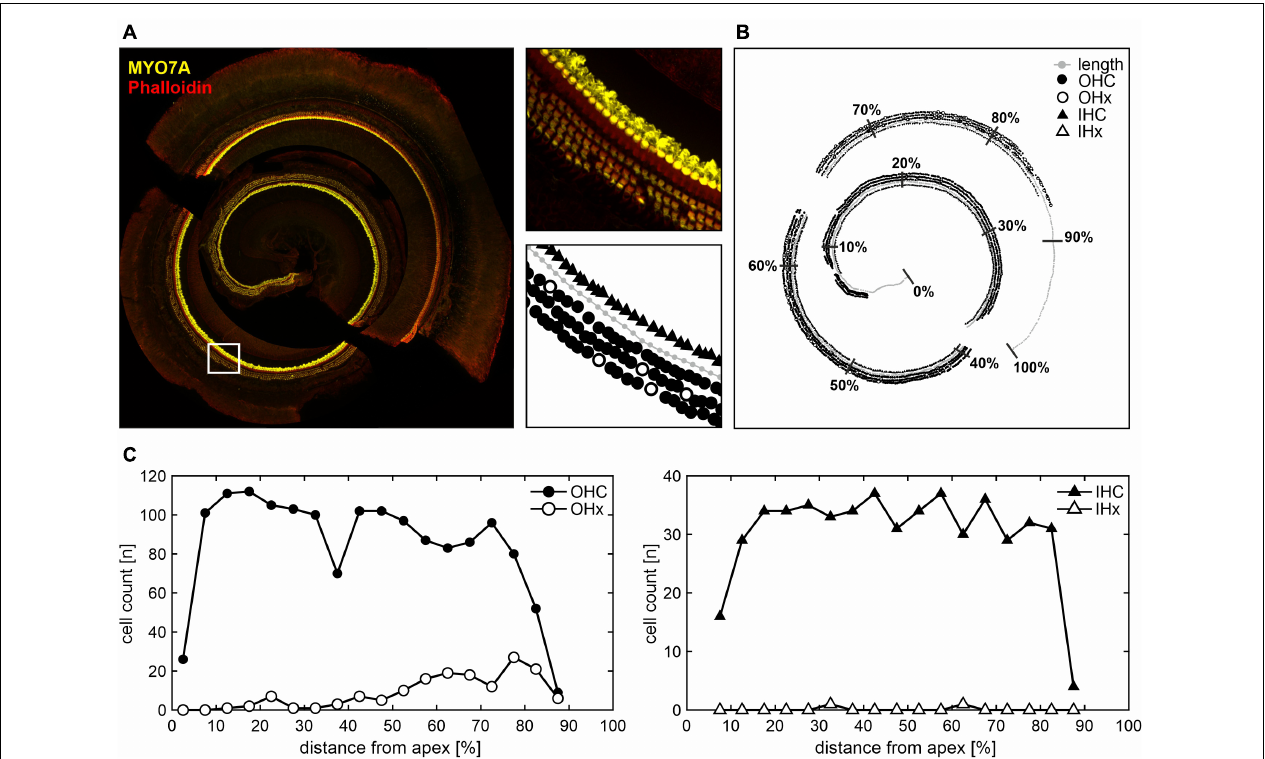
FIGURE 4 | Hair cell count along the cochlear spiral length in whole-mount histological analysis. (A) Illustrative example of apical, middle, and basal cochlear segments stained with MYO7A for hair cells and phalloidin for stereocilia (left panel). In the white-square delimited area, different marker assignments are illustrated (right panels): cochlear length axis (gray circles), present or missing outer hair cells (OHC as black circles, or OHx as white circles, respectively), and present or missing inner hair cells (IHC as black triangles, or IHx as white triangles, respectively). (B) The corresponding overview is shown with the cochlear length normalized to 100% distance from apex and subdivided into 10% bins. Due to preparation difficulties, some whole-mount segments were only partially intact, e.g., in the 90–100% range. These were not included in the analysis, i.e., no hair cell markers were assigned, whereas the length axis was still used to approximate the total cochlear spiral length. (C) Present or missing OHC (left panel) and IHC (right panel) counts are shown as a function of the relative distance from apex in 5% bins, with the cell count plotted in the middle of the respective bin. Note that entire bins without valid hair cell markers were excluded, while bins with only partially valid markers due to preparation difficulties were included, but showed generally lower cell